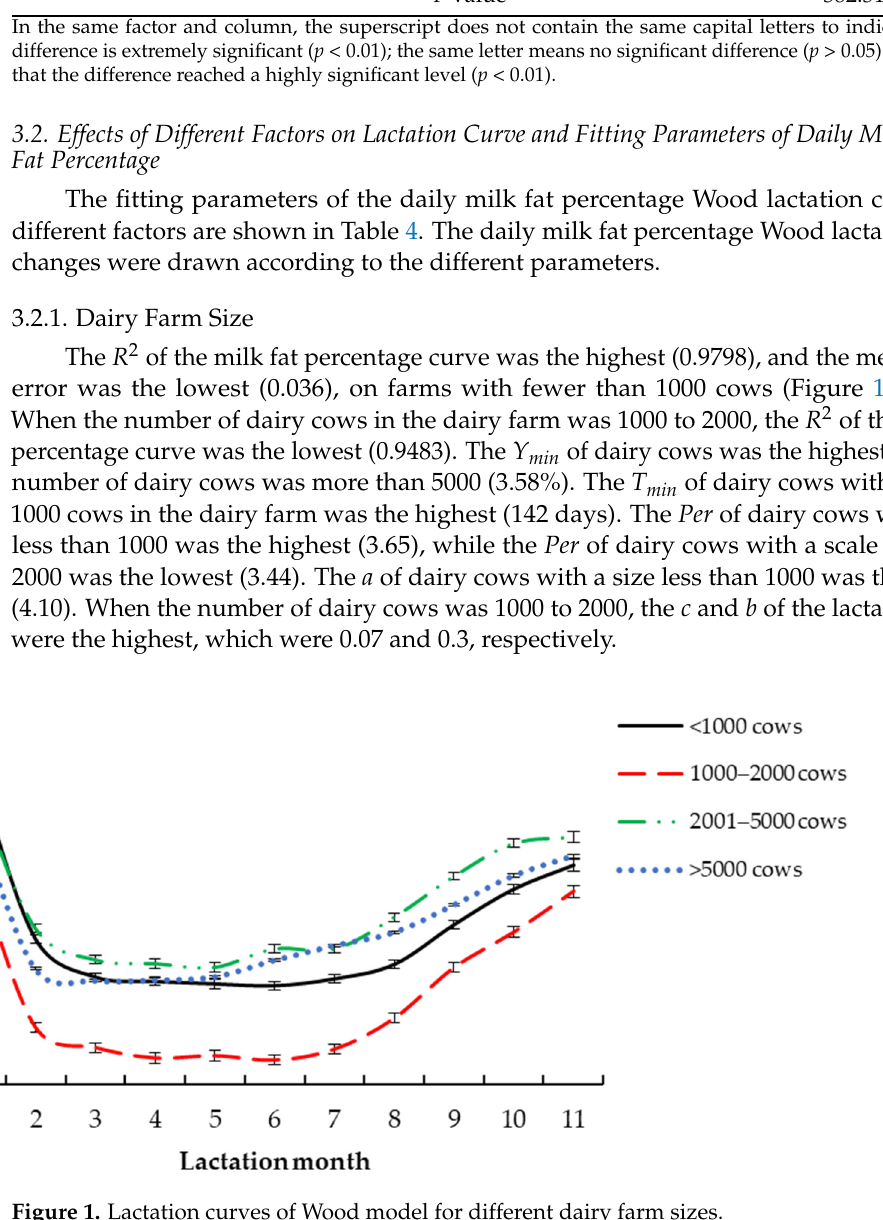
Figure 1. Lactation curves of Wood model for different dairy farm sizes.